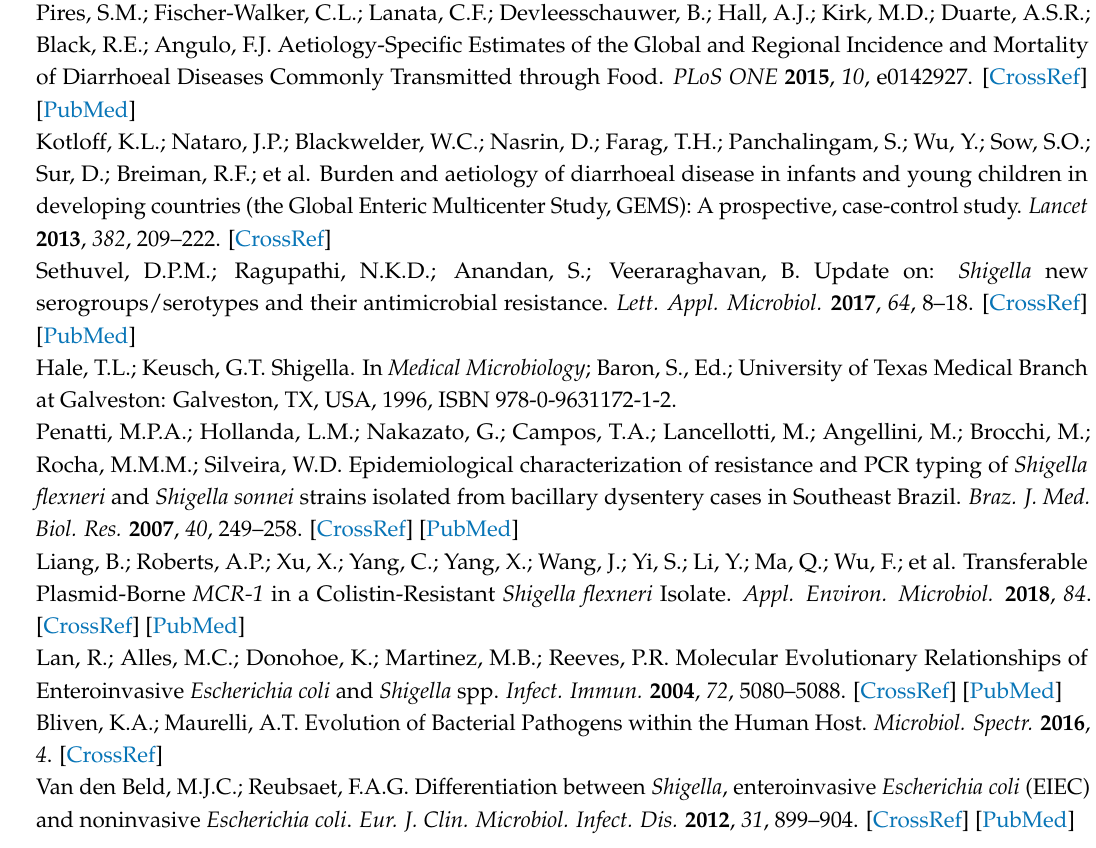
Figure S1: Chromatogram of digested SfY ScBp and MS data, Figure S2: Chromatogram of digested SfY 99–2001 polysaccharide and MS data, Figure S3: Chromatogram of digested SfY 03–650 polysaccharide and MS data, Figure S4: Chromatogram of digested Sf2a ScBp and MS data, Figure S5: Chromatogram of digested Sf2a 03–6557 polysaccharide and MS data, Figure S6: Chromatogram of Sf2a 08–7230 polysaccharide and MS data, Figure S7: Organic solvent stability of Sf6TSP, Figure S8: Binding kinetics of Sf6TSP N340C labeled with NBD to SfY polysaccharide, Table S1: Annotated masses from MALDI-TOF MS from digested SfY ScBp polysaccharide, Table S2: Annotated masses from MALDI-TOF MS from digested SfY 99–2001 polysaccharide, Table S3: Annotated masses from MALDI-TOF MS from digested SfY 03–650 polysaccharide, Table S4: Annotated masses from MALDI-TOF MS from digested Sf2a ScBp polysaccharide, Table S5: Annotated masses from MALDI-TOF MS from digested Sf2a 03–6557 polysaccharide, Table S6: Annotated masses from MALDI-TOF MS from digested Sf2a 08–7230